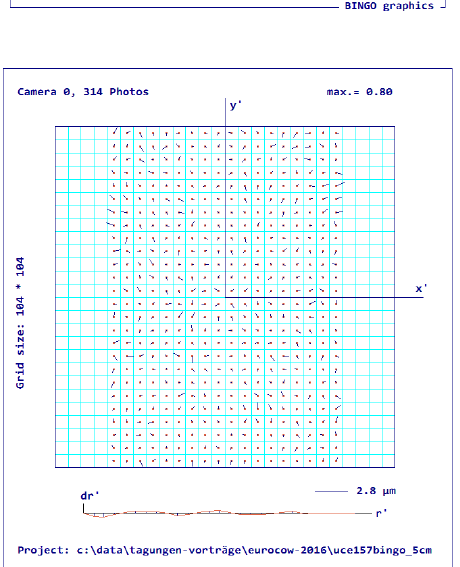
Fig 2: Temperature Readings from the UltraCam Eagle large format camera